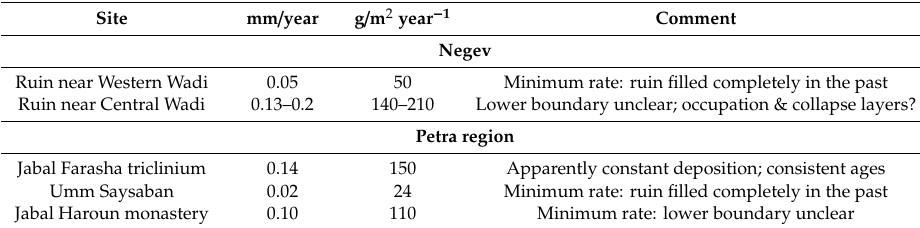
Table 4. Average dust sedimentation rates calculated for the ruin soils in the Negev and Petra